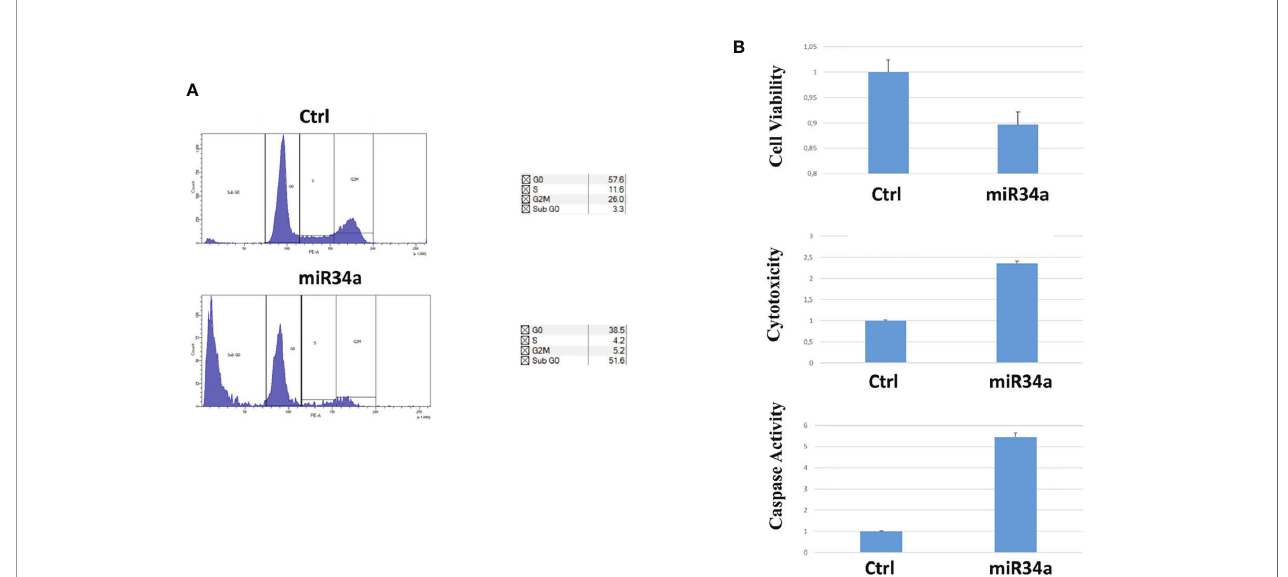
FIGURE 4 | Evaluation of miR34a overexpression effect on Huh7.5: (A) propidium iodide cell cycle analysis and (B) cell viability, cytotoxicity, and caspase activation (the analysis was carried out in triplicate; p value ≤ 0.05).